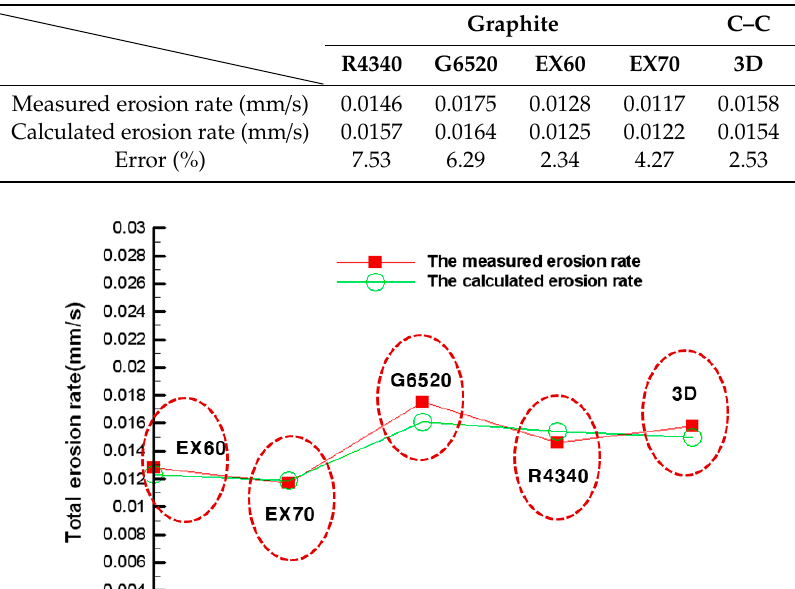
Table 5. The calculated and measured erosion rate of graphite and the C–C composite.